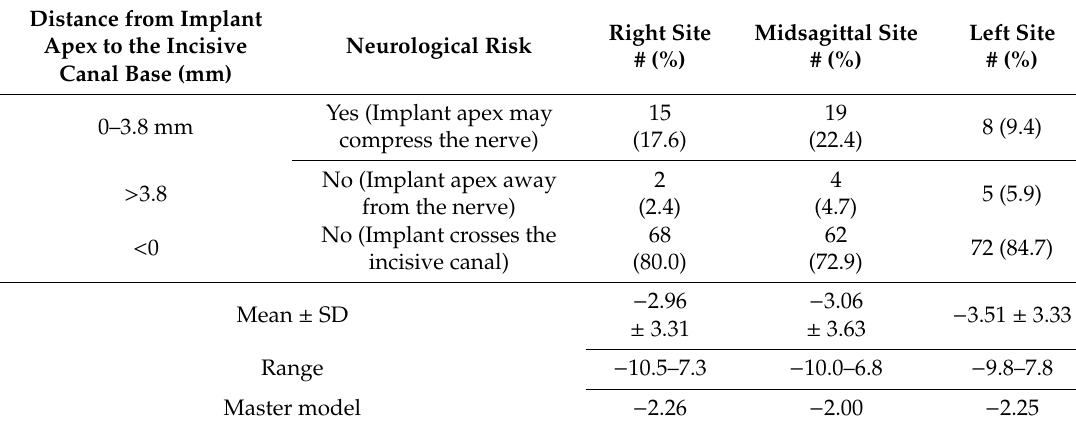
Table 4. Distance from implant apex to the incisive canal